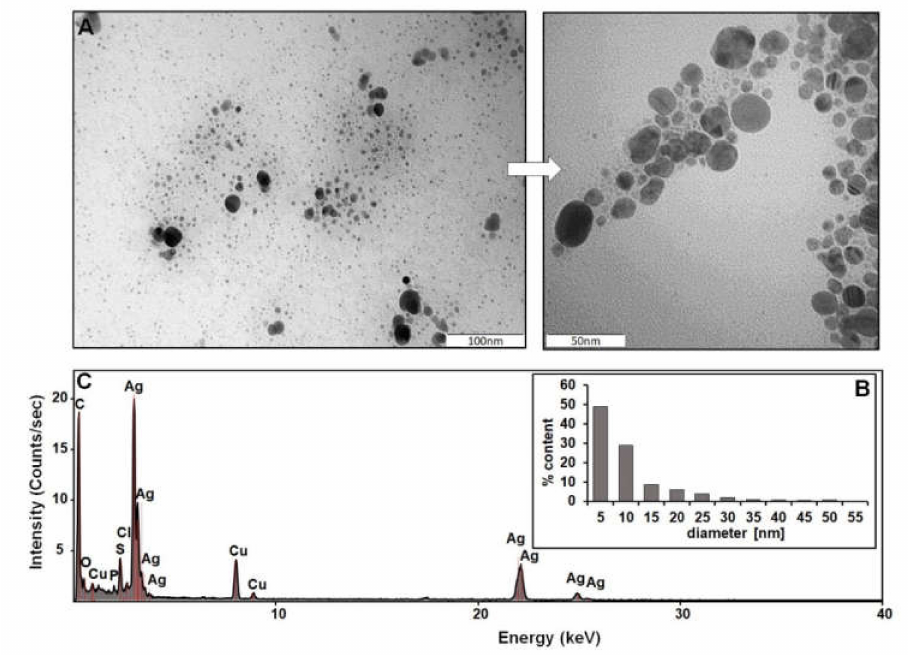
Figure 1. Characteristics of (Bio)Ag NPs: TEM image of Ag NPs ( A ), size distribution ( B ), energy- dispersive X-ray spectroscopy (EDS), and analysis ( C